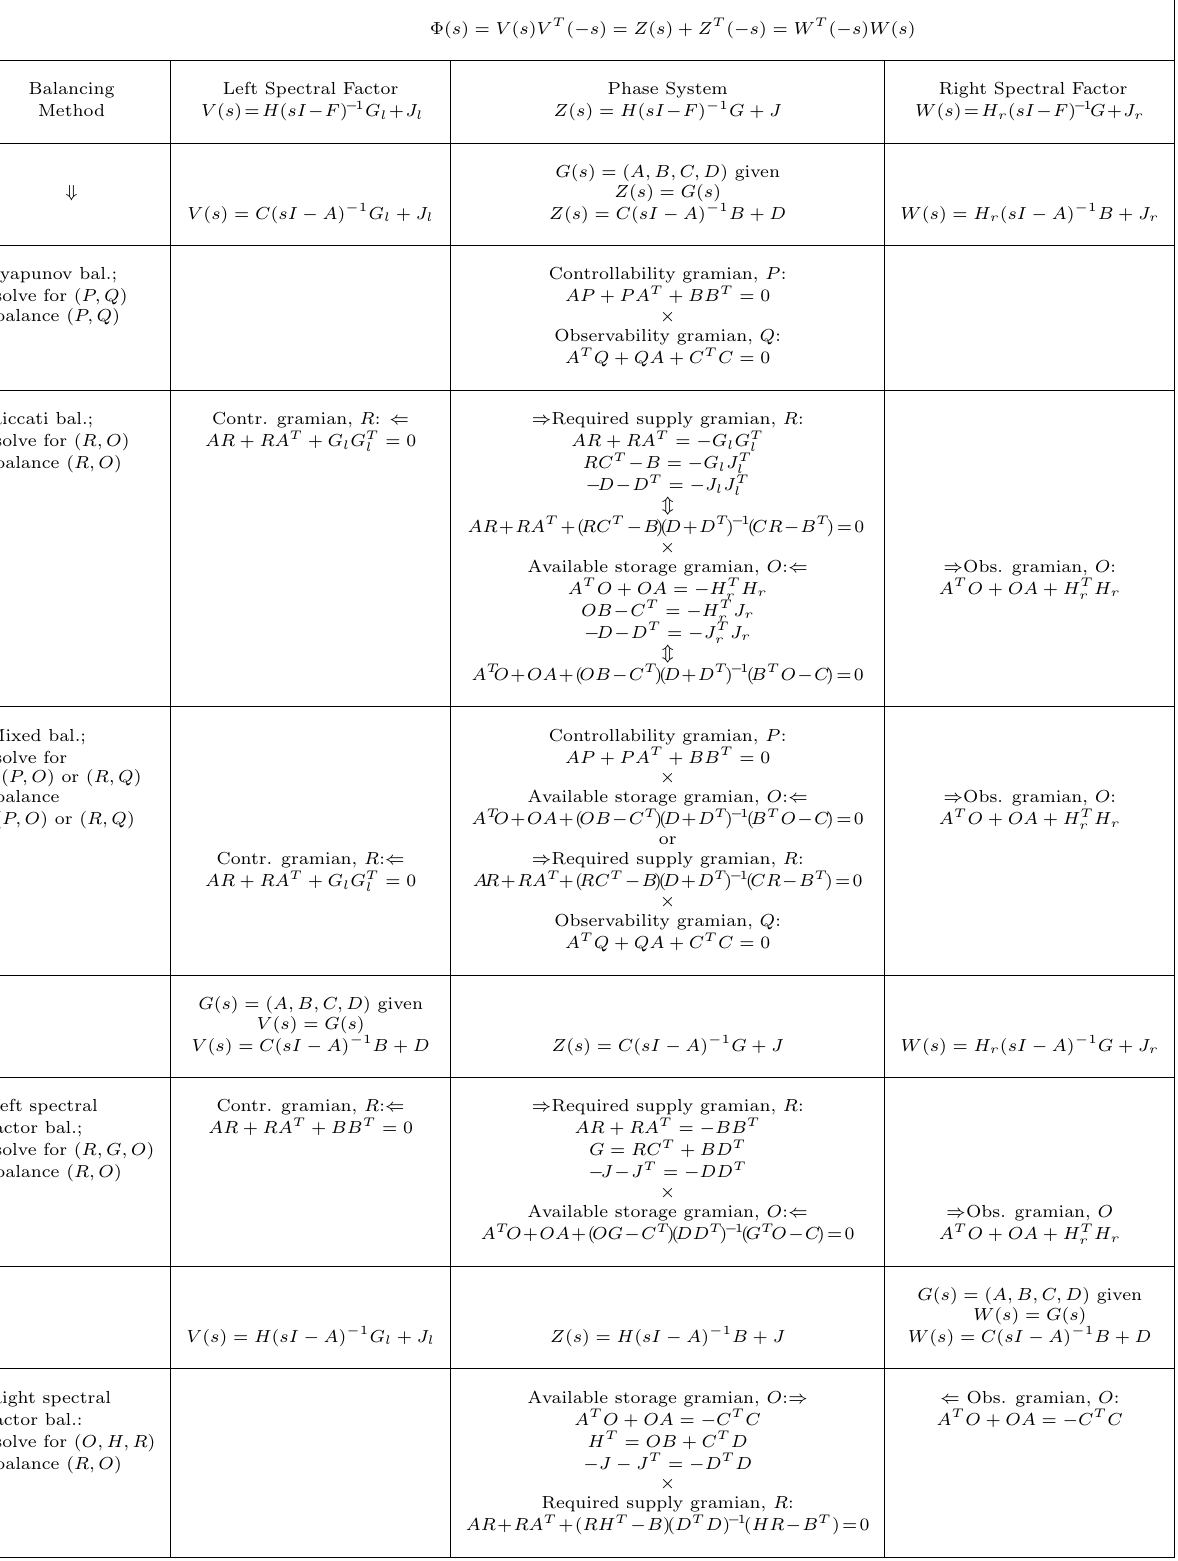
Table 2: Overview over the different balancing schemes and associated equations to be solved